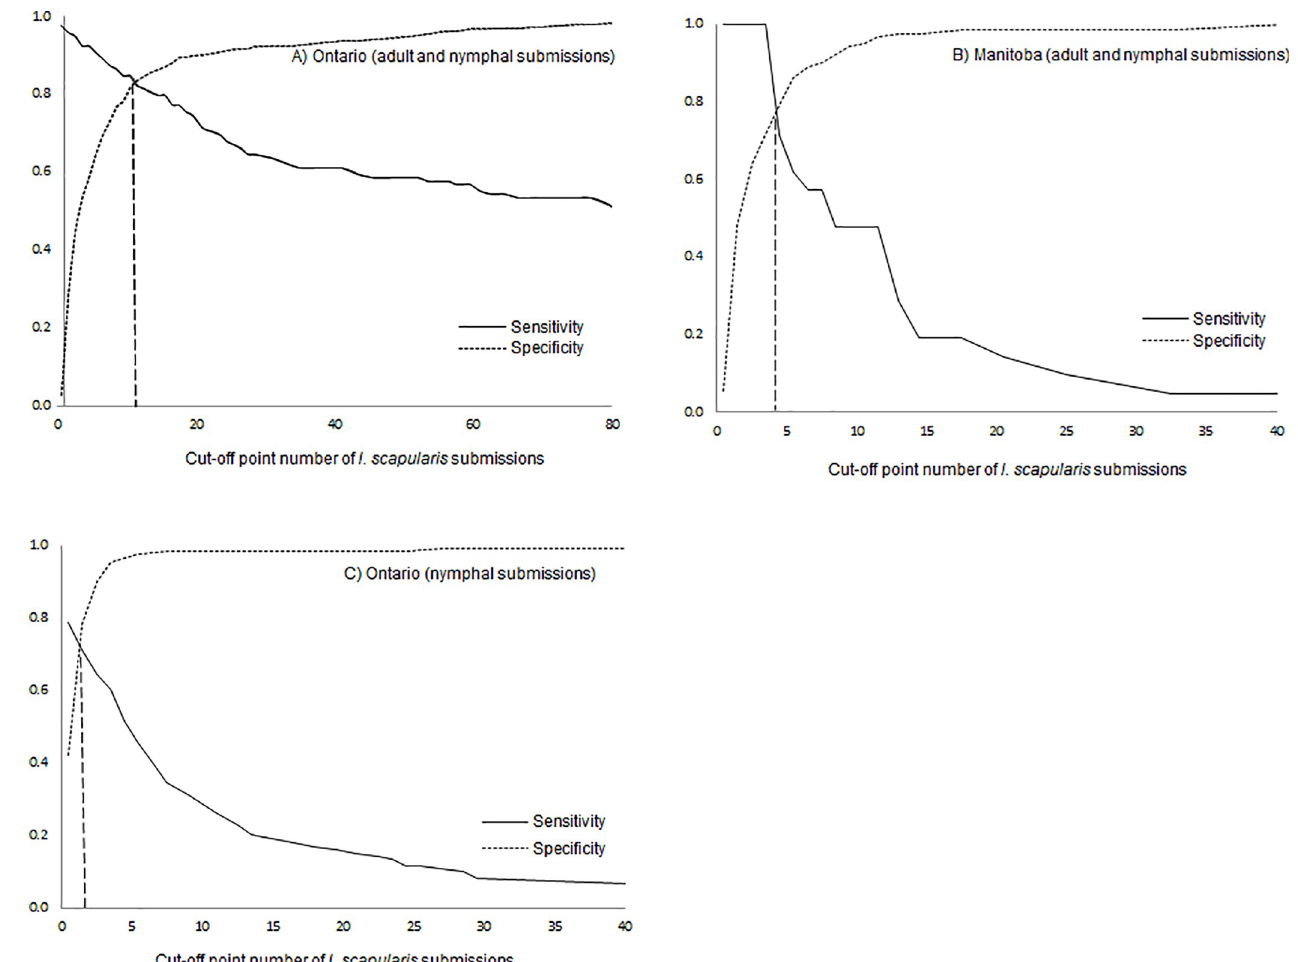
Fig 2. Sensitivity and specificity curves of the range of cut-off point number of I . scapularis (adults and nymphs) submissions in Ontario and Manitoba (A and B) and nymphal I . scapularis submissions in Ontario (C). The straight dashed line corresponds to the intersection between Se and Sp curves, the optimal cut-off point which maximize the Se and Sp over a range of cut-off points of the number of tick submissions. A − C illustrate the optimal cut-off points of cumulated 12, 5 and 2 tick submissions over five-year period to discriminate CSDs with � 3 human Lyme disease